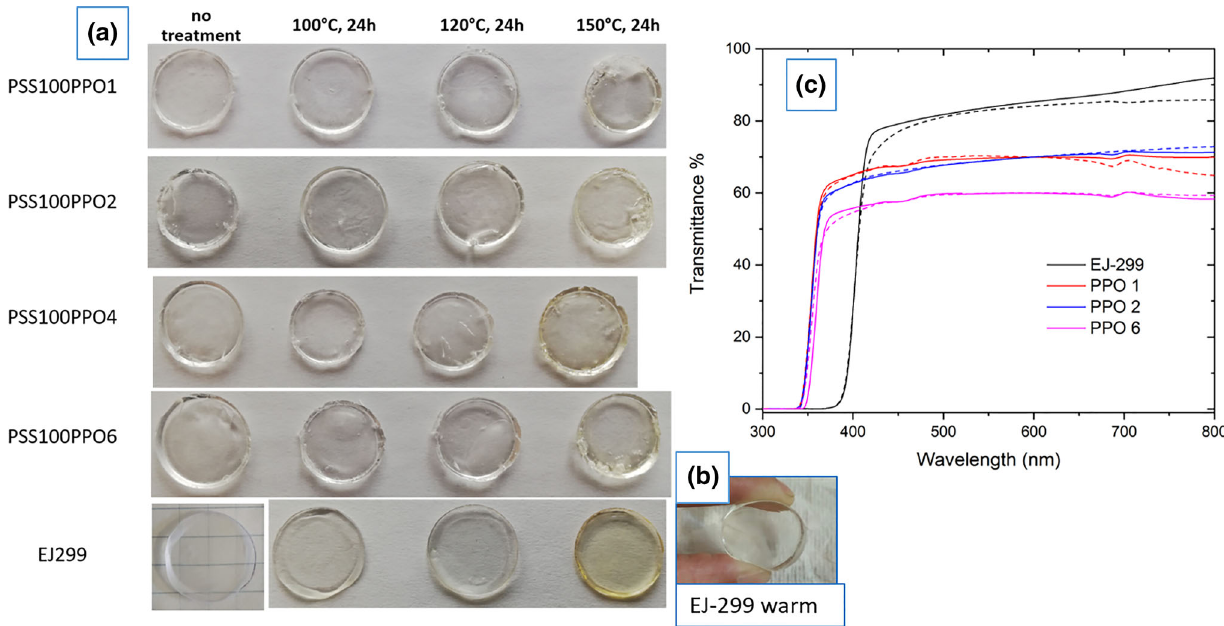
Fig. 3 a Images of the siloxane scintillators and the commercial one EJ-299 after annealing at different temperatures; b photo of the still warm EJ-299 after heating at 100 ◦ C during manual compression; c